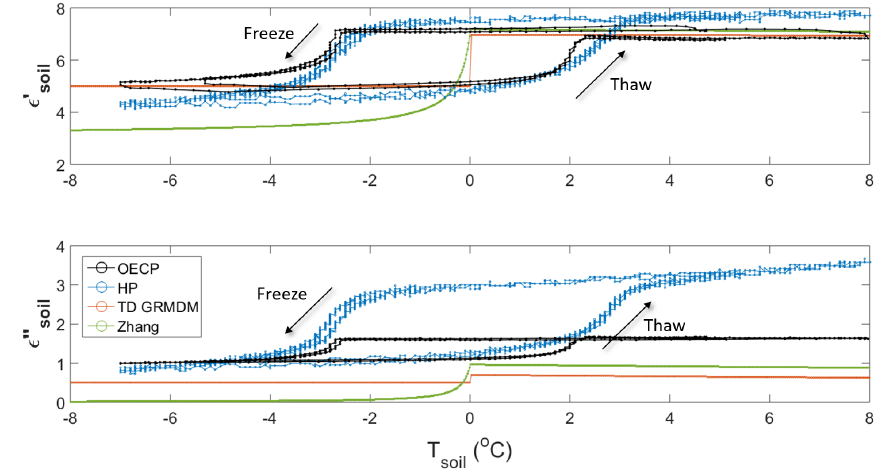
Figure 6. Same as Fig. 5 but for the sandy loam soil sample (see Table 1). Experiment conducted from 15 to 19 April 2018.